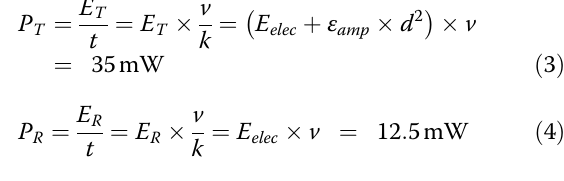
Fig. 8 Network topology construction results based on PSO. This figure shows an example of a network construction with the lowest power consumption obtained by the PSO algorithm. Here, the red node is the coordinator, the yellow node is the router, and the green node is the end-device. It can be observed that the number of routers is 8, and the number of end-devices is 91